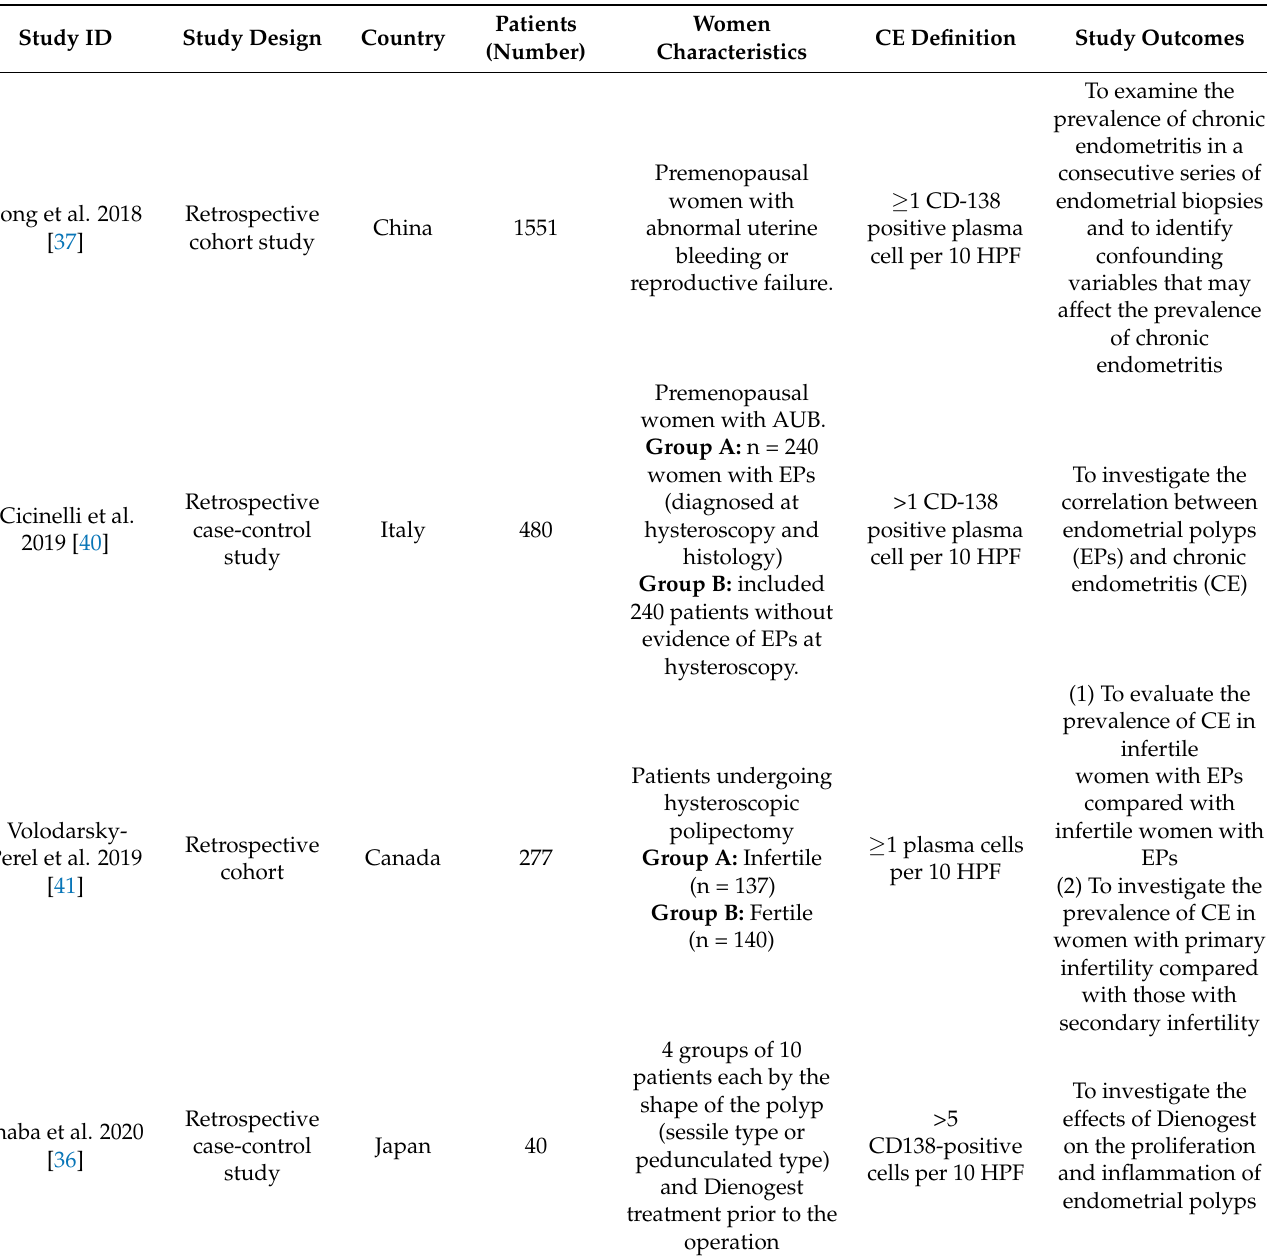
Table 1. General features of included